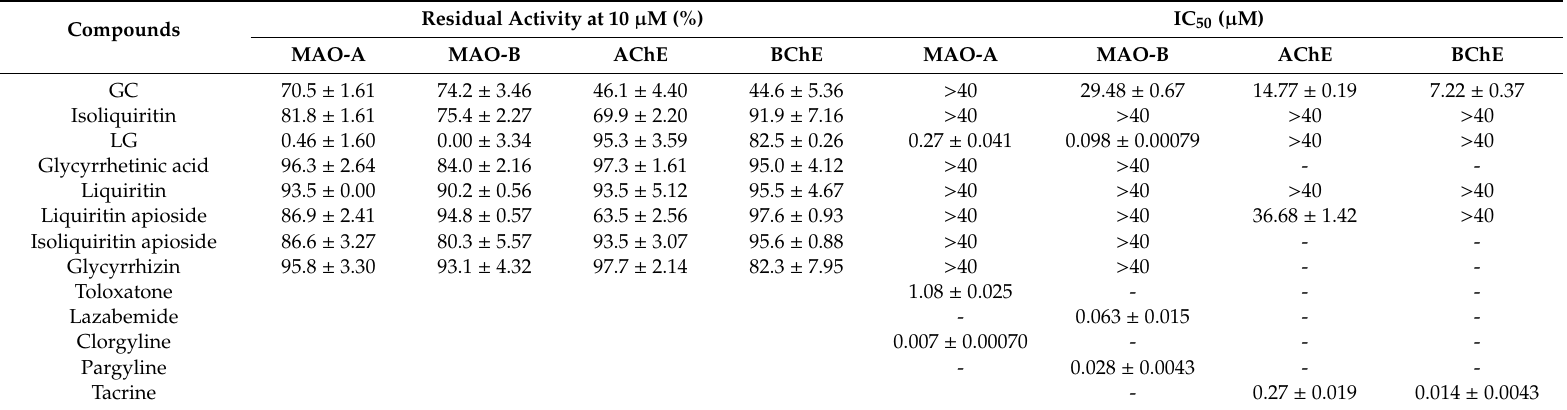
Table 1. Inhibitions of AChE, BChE, MAO-A, and MAO-B by compounds isolated from the roots of Glycyrrhiza uralensis .